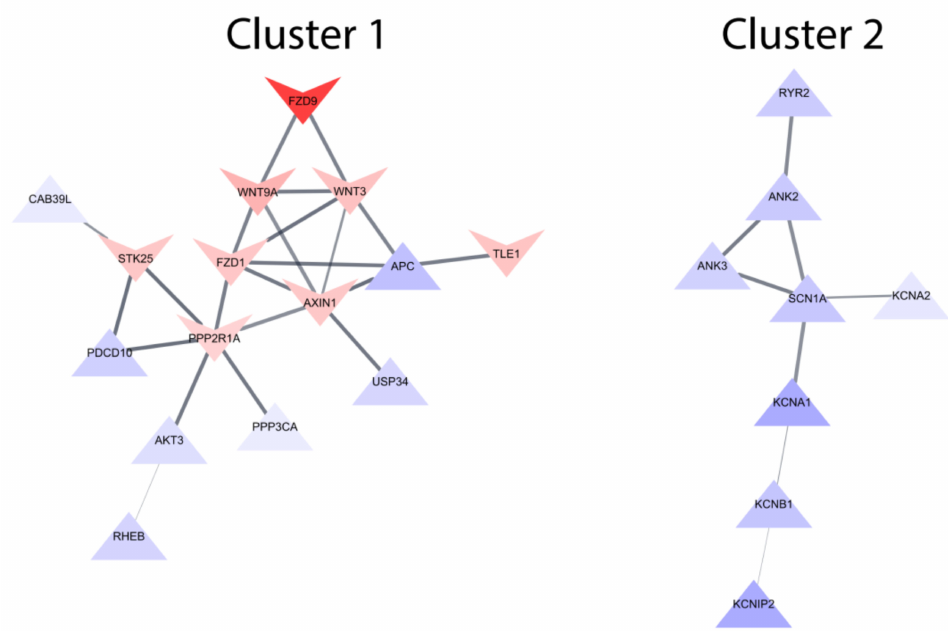
Figure 4. Clusters of protein-protein interaction networks of the commonly reversed genes by four antipsychotic drugs. Cluster 1 and 2 are the two largest connected components of biologically related proteins. Triangular nodes are genes upregulated by all studied antipsychotics, whilst v-shaped nodes represent downregulated genes. Nodes are colored based on mean log fold change (red: downregulation, blue: upregulation). Edge width represents the confidence of the STRING interaction score graded by supporting evidence (from cut-off minimum score 0.7 to maximum score 1). Proteins without interactions are not